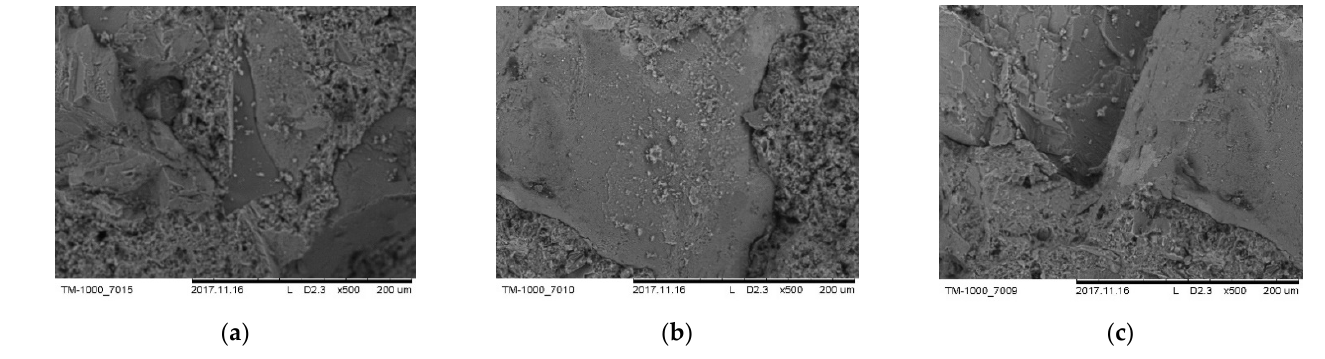
Figure 9. Microstructure of concretes made of: ( a ) dunite, ( b ) wehrlite, ( c ) troctolite.